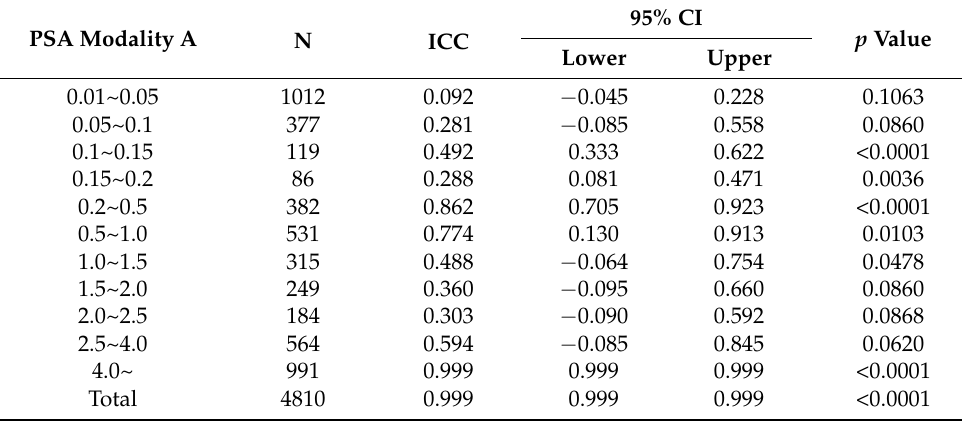
Table 1. Analysis of agreement between two PSA assay modalities.